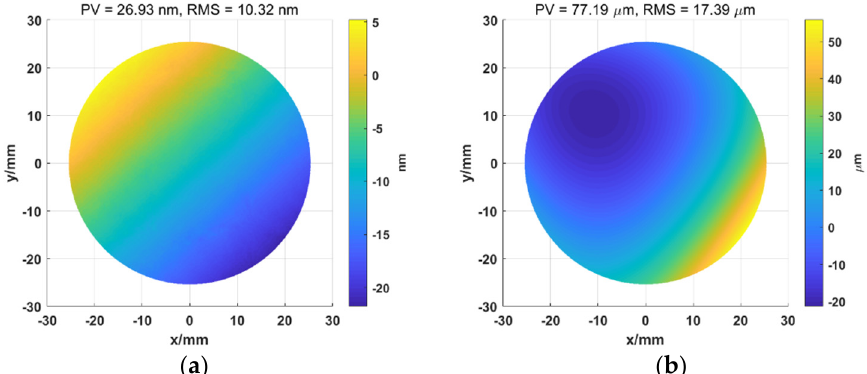
Figure 7. The residual map between the reference model and the reconstructed model of mirrors. ( a ) The residual map of the planar mirror; the RMS of error is 10.32 nm. ( b ) The residual map of the concave mirror; the RMS value of error is 17.39 μ m.